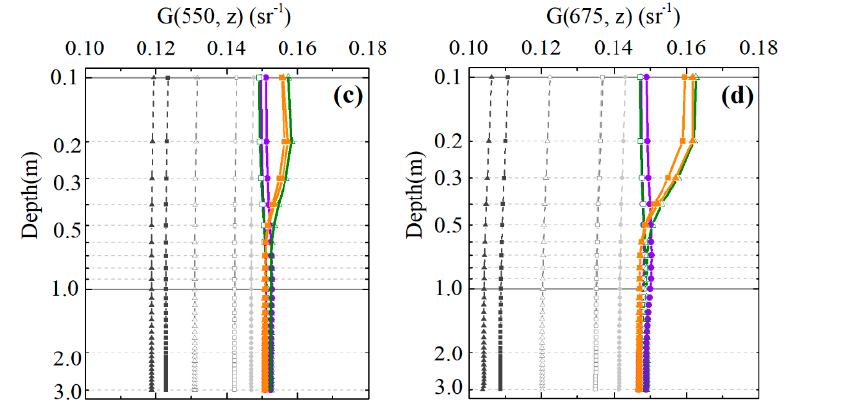
Figure 3. r rs ( λ , z) of Chl a (z) vertical profiles (L1–L6) at ( a ) 550 and ( b ) 675 nm. G( λ , z) of Chl a (z) vertical profiles (L1–L6) at ( c ) 550 and ( d ) 675 nm. Different lines represent different vertical structure parameters (C 0 , h, σ ) of Chl a (z) profiles: L1 (5, 16, 0.6), L2 (10, 16, 0.6), L3 (10, 21, 0.6), L4 (5, 16, 0.2), L5 (10, 16, 0.2), and L6 (10, 21, 0.2). The grey dashed lines represent the corresponding homogeneous